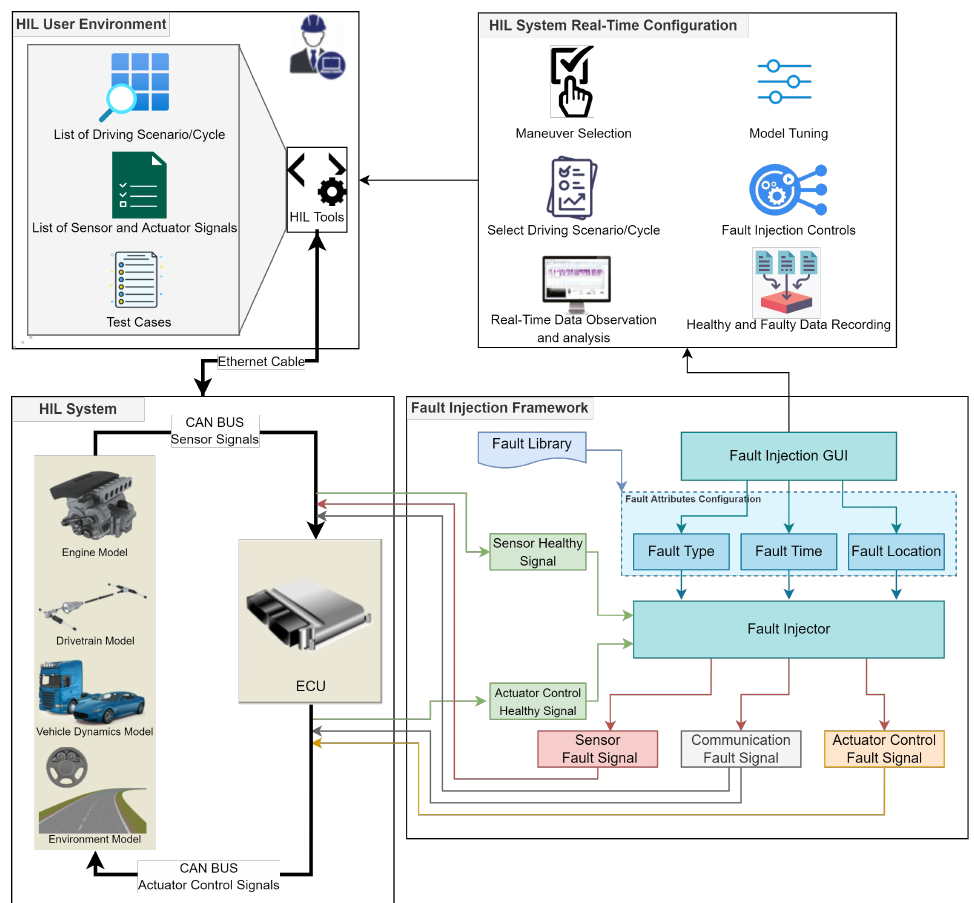
Figure 2. HiL-based real-time fault injection